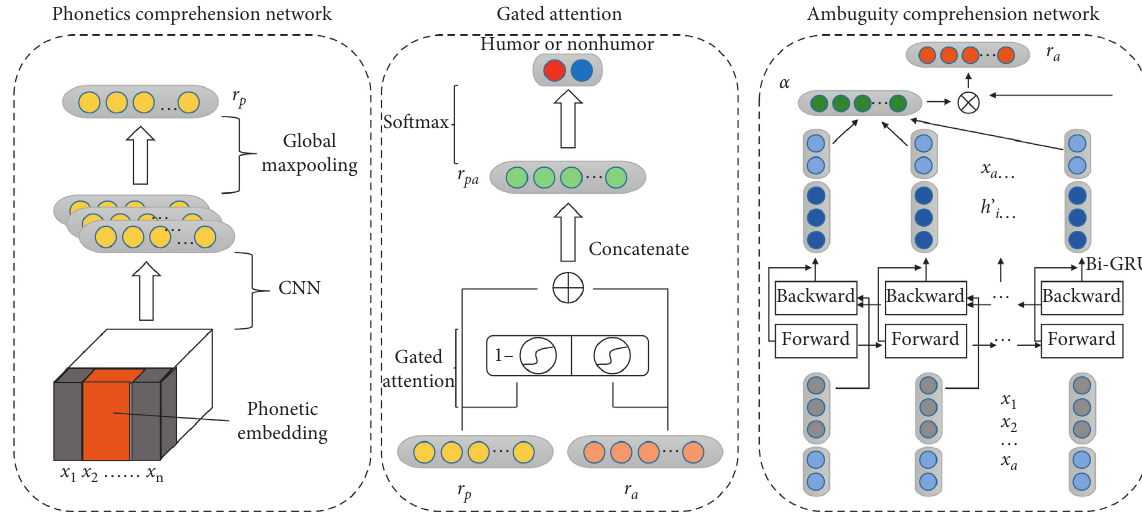
Figure 1: The Framework of Phonetics and Ambiguity Comprehension Gated Attention